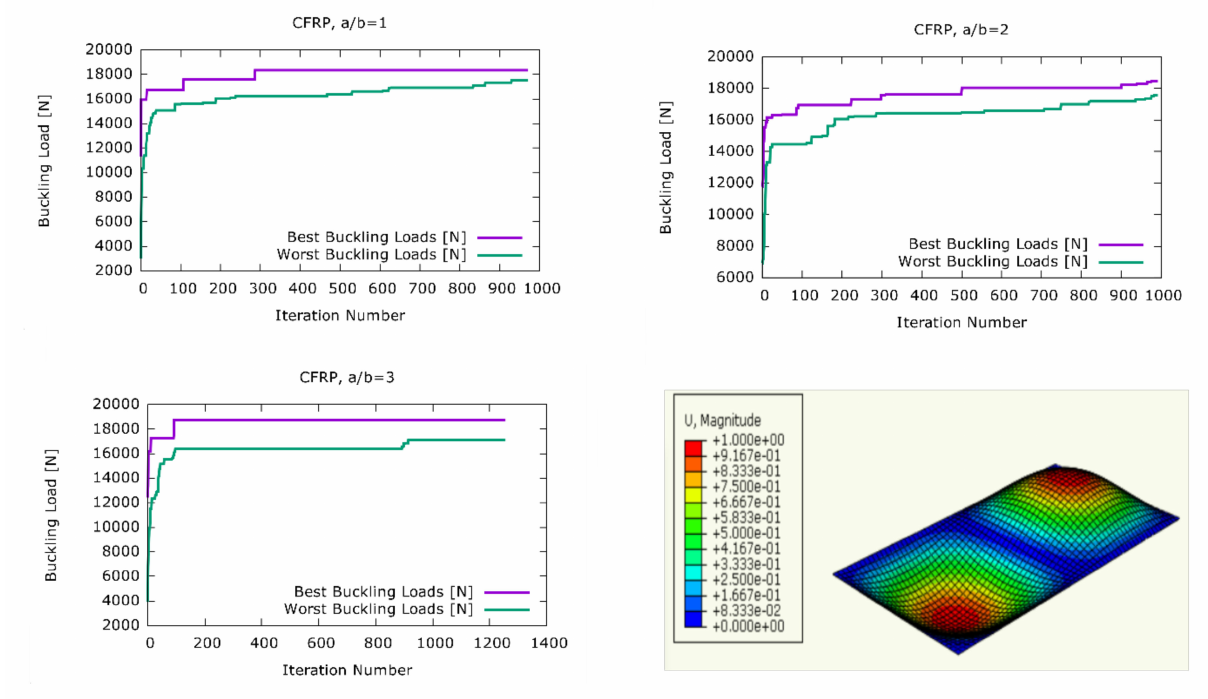
Figure 9. Buckling load optimization of CFRP plates without cut-outs under uniaxial compression parallel to the longer edge